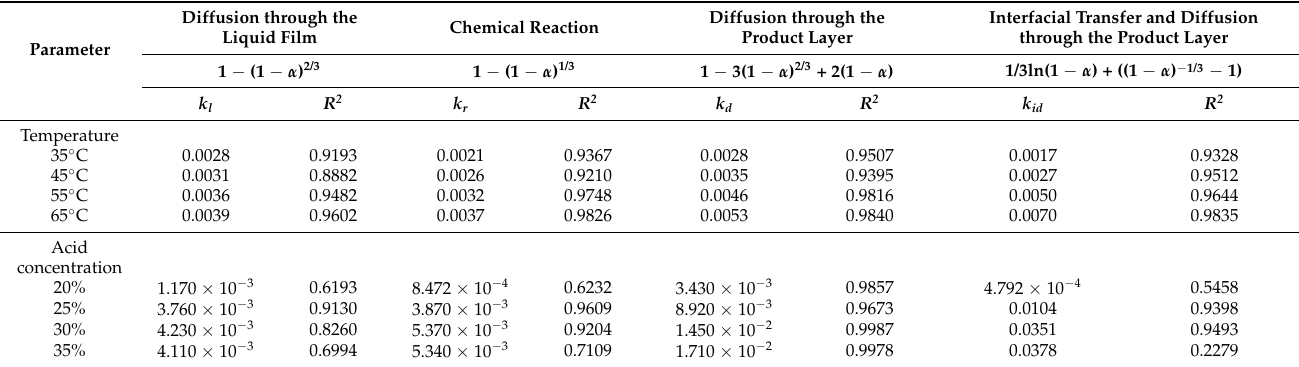
Diffusion through the Interfacial Transfer and Diffusion Product Layer through the Product